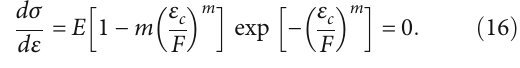
Figure 11: Chemical damage parameters and elastic